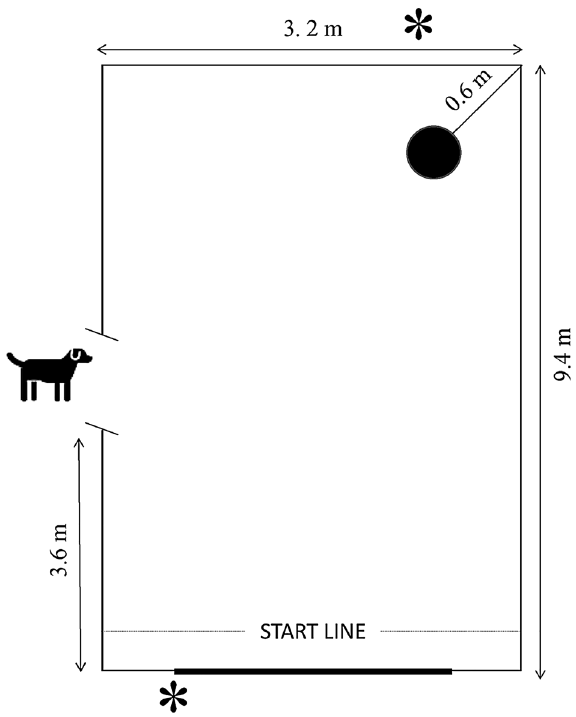
Figure 4. Schematic layout of the attention bias arena. The black circle is the positive cue (i.e. a bucket with 500 g concentrates) and the dog is the threat (dog model). The stars show the locations of the cameras.